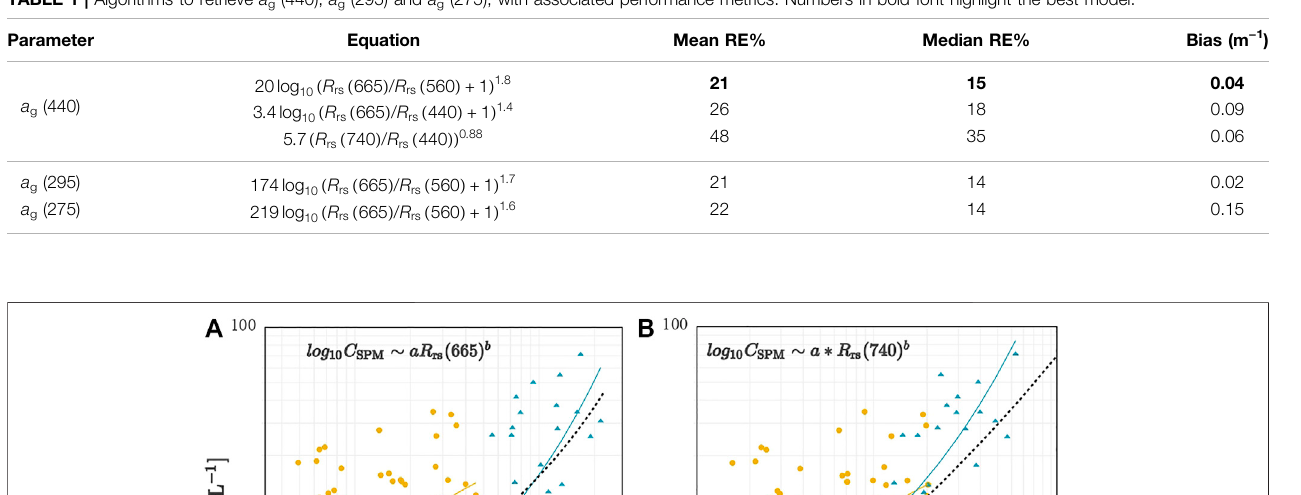
Frontiers in Remote Sensing |